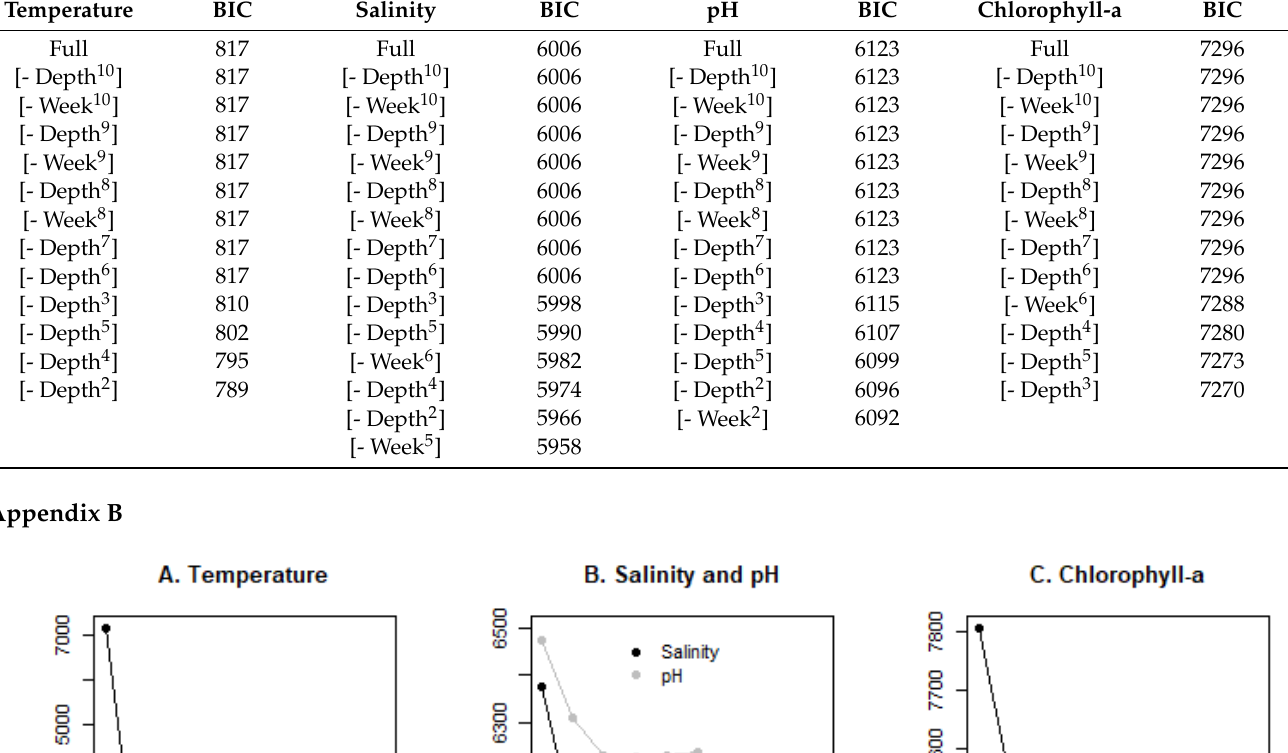
Table A1. Stepwise observation-level regression results for the four response variables: BIC of each model variant after elimination of one term.